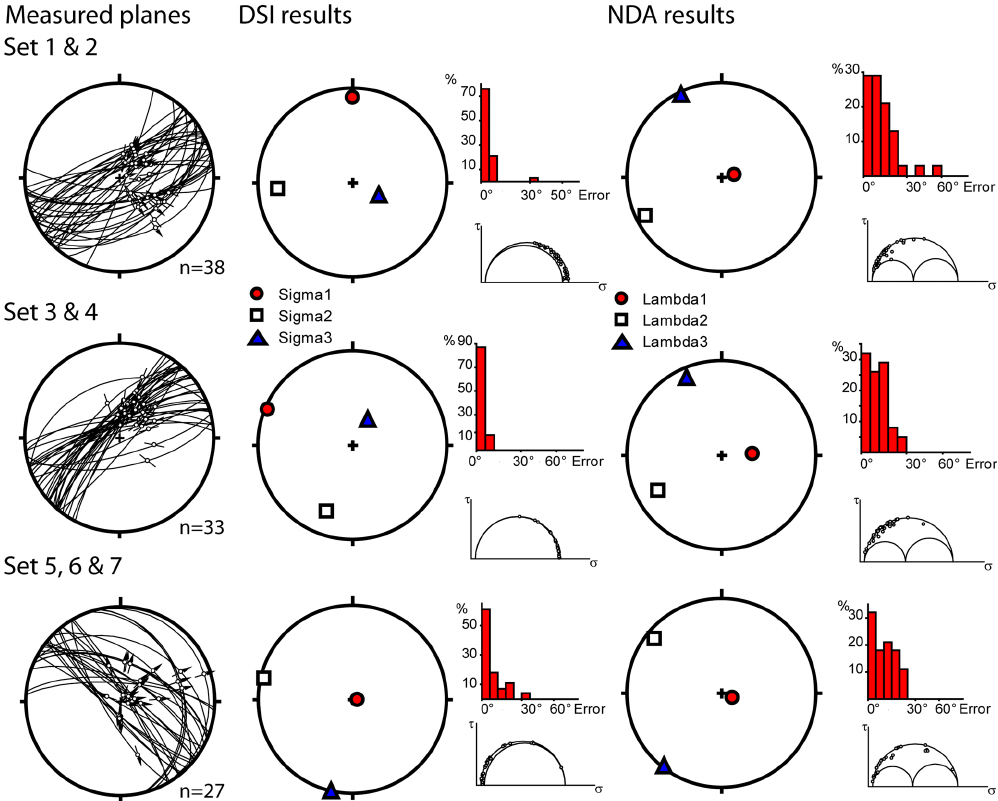
Figure 6. Fault plane orientation–slip direction and palaeostress (DSI) and palaeostrain (NDA) results (for the three sets) from CHJ (Fig. 3a). The separation is based on Johansen et al. (2005), with kinematically related sets combined into a single data